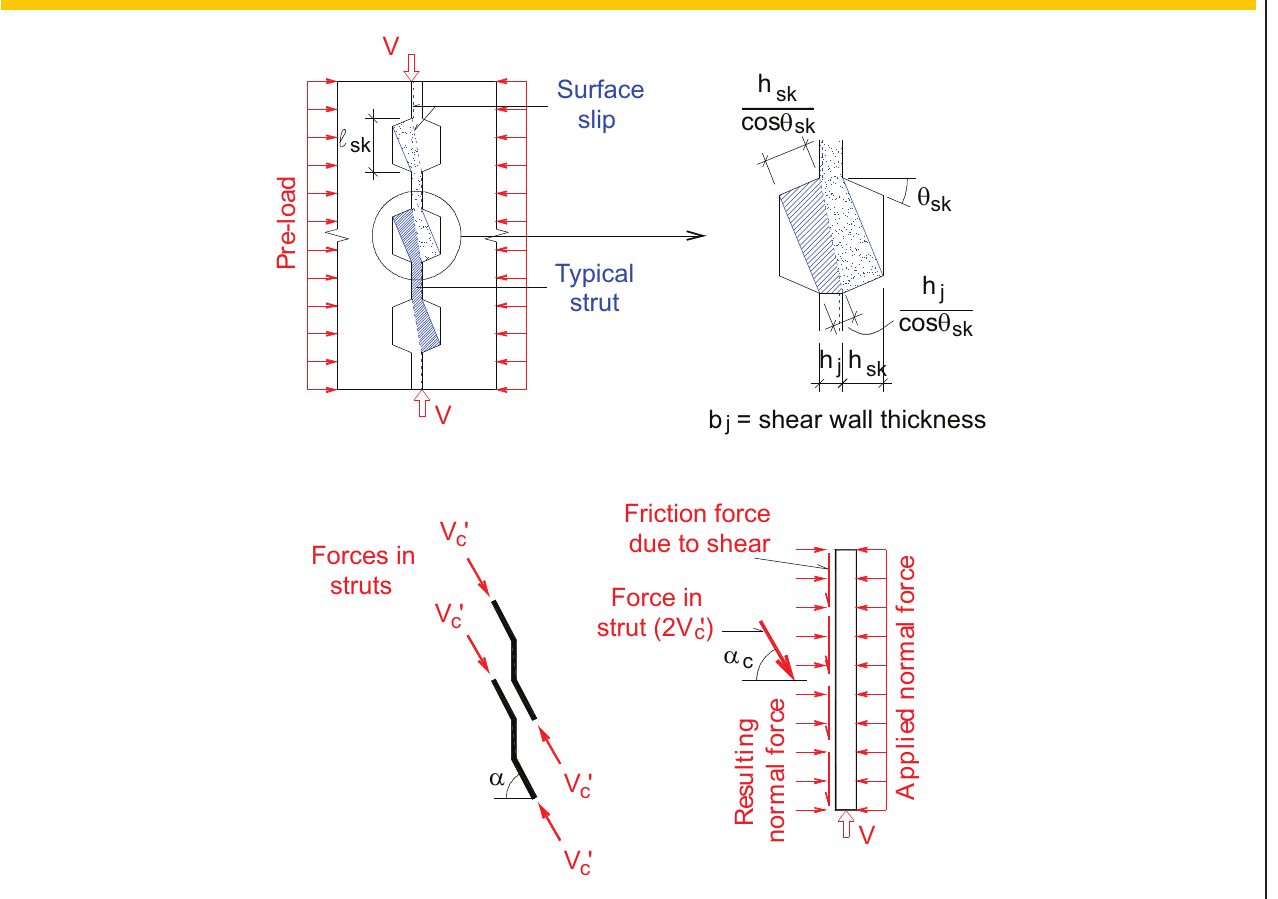
Figure 1 – Model for determining the maximum shear strength (Rizkalla et al.